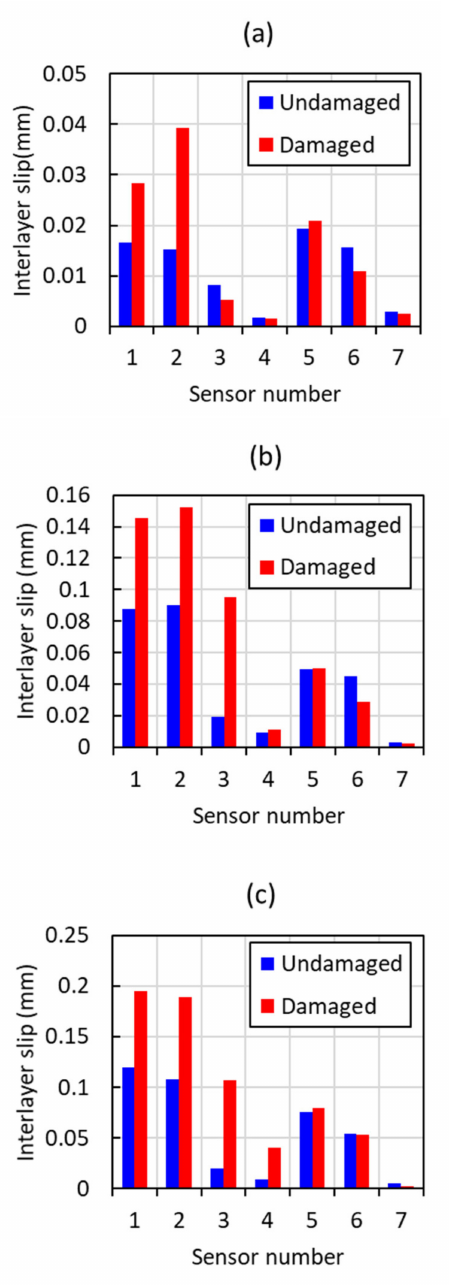
Figure 12. Structural damage detection for single damage in terms of ( a ) first load increment, ( b ) second load increment and ( c ) third load